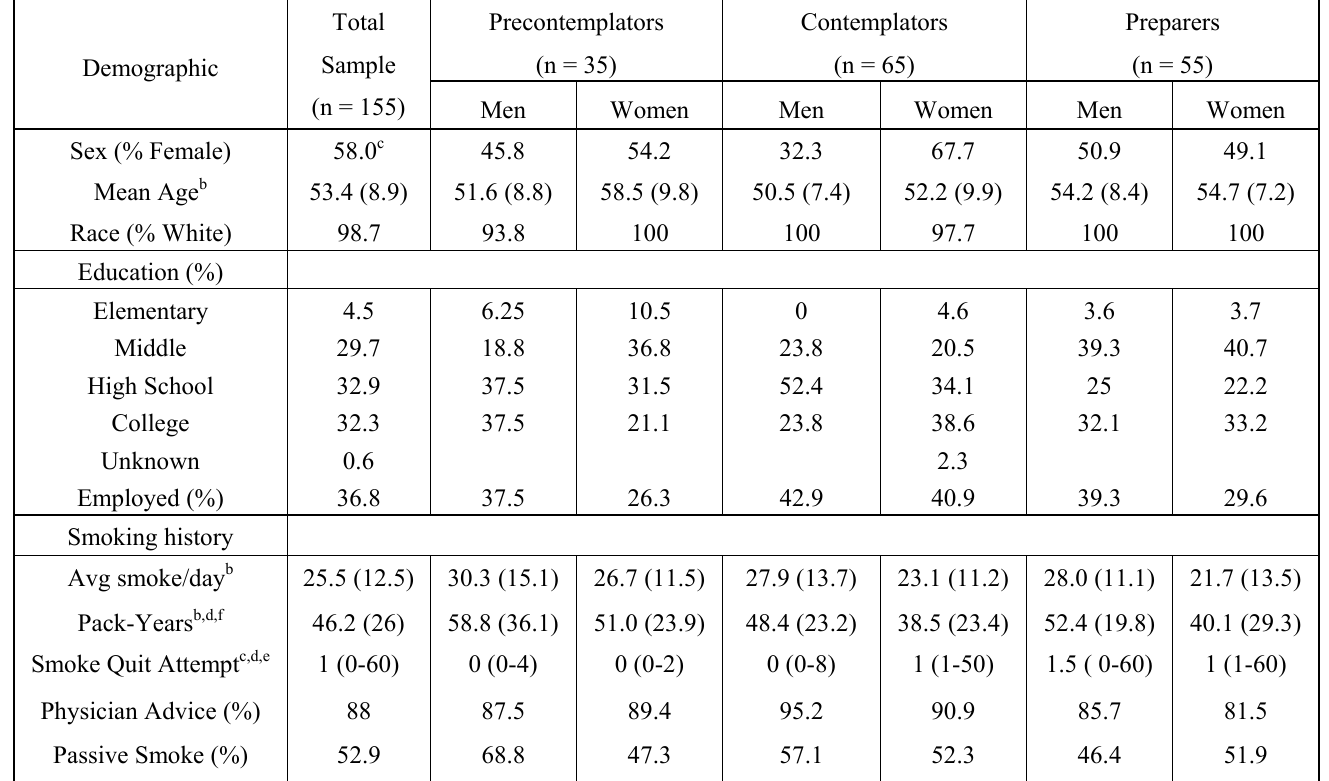
Table 1. Demographics of study participants by stage of change